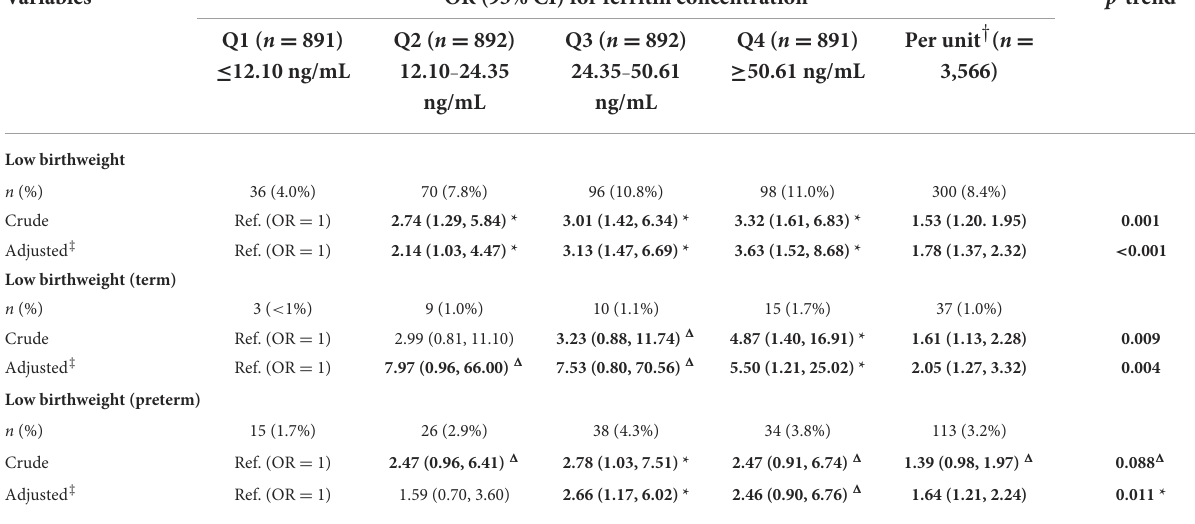
TABLE 2 Risk of low birthweight and subcategories associated with maternal serum ferritin concentration.